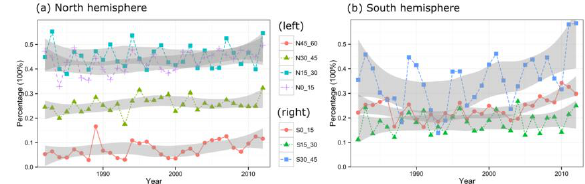
Figure 6. Changes in the percentage of multiple cropping system (double or triple cropping zones) along geographic latitude zones with 15o latitude intervals from 60 o N to 45 o S over the past three decades. (a) Changes in percentage of multiple cropping system in the north hemisphere, and (b) the corresponding changes in the south hemisphere. In (a) and (b) the scatters indicate the upward trends of zones N45 o _60 o ( p = 0.015), N30 o _45 o ( p = 0.050), N0 o _15 o ( p = 0.011), S0 o _15 o ( p = 0.012), and S30 o _45 o ( p = 0.040) are statistically significant, while the insignificant trends are shown in zones N15 o _30 o ( p = 0.797) and S15 o _30 o ( p = 0.255). Noted that limited cropland is distributed above S45 o , thus we only show three zones including S0 o _15 o , S15 o _30 o , and S30 o _45 o in the south